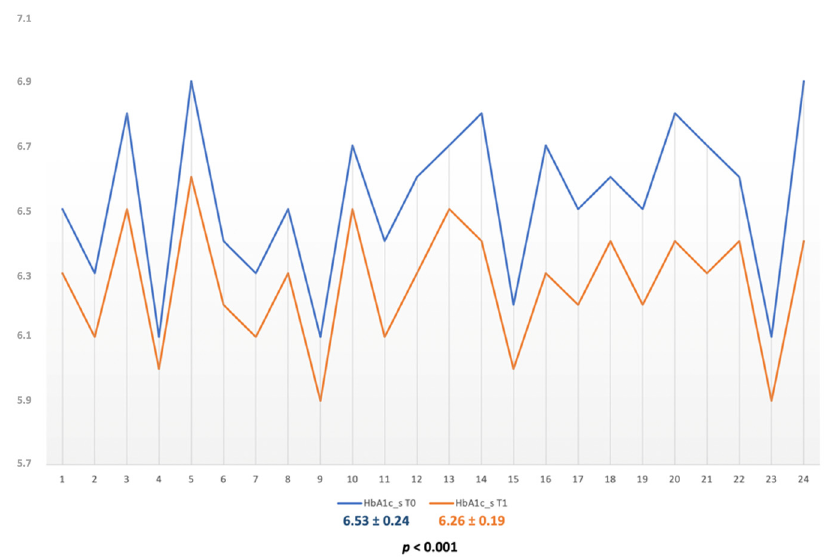
Figure 2. HbA1c variations in the SRP group.